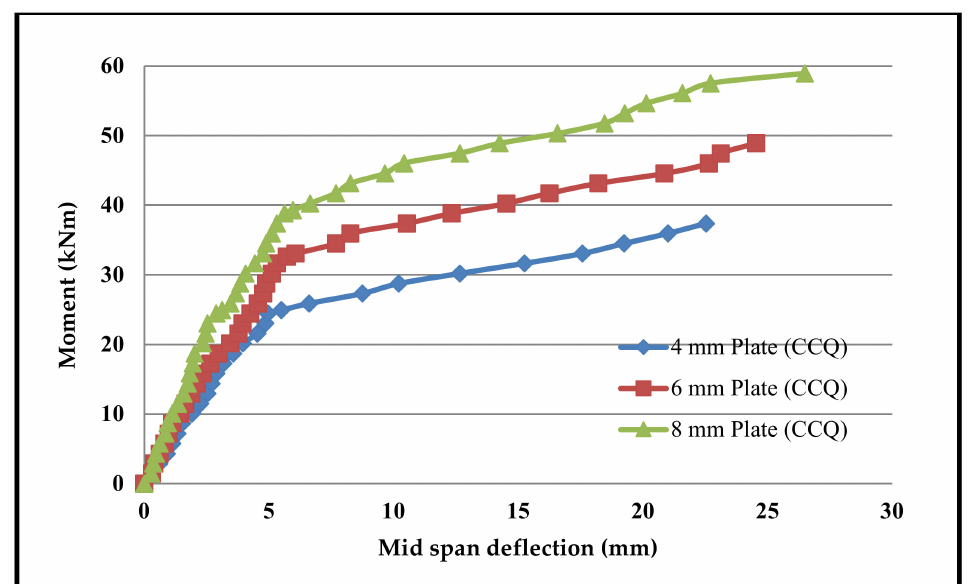
Figure 16. Moment–deflection curve for SCS beams used with CCQ mix.